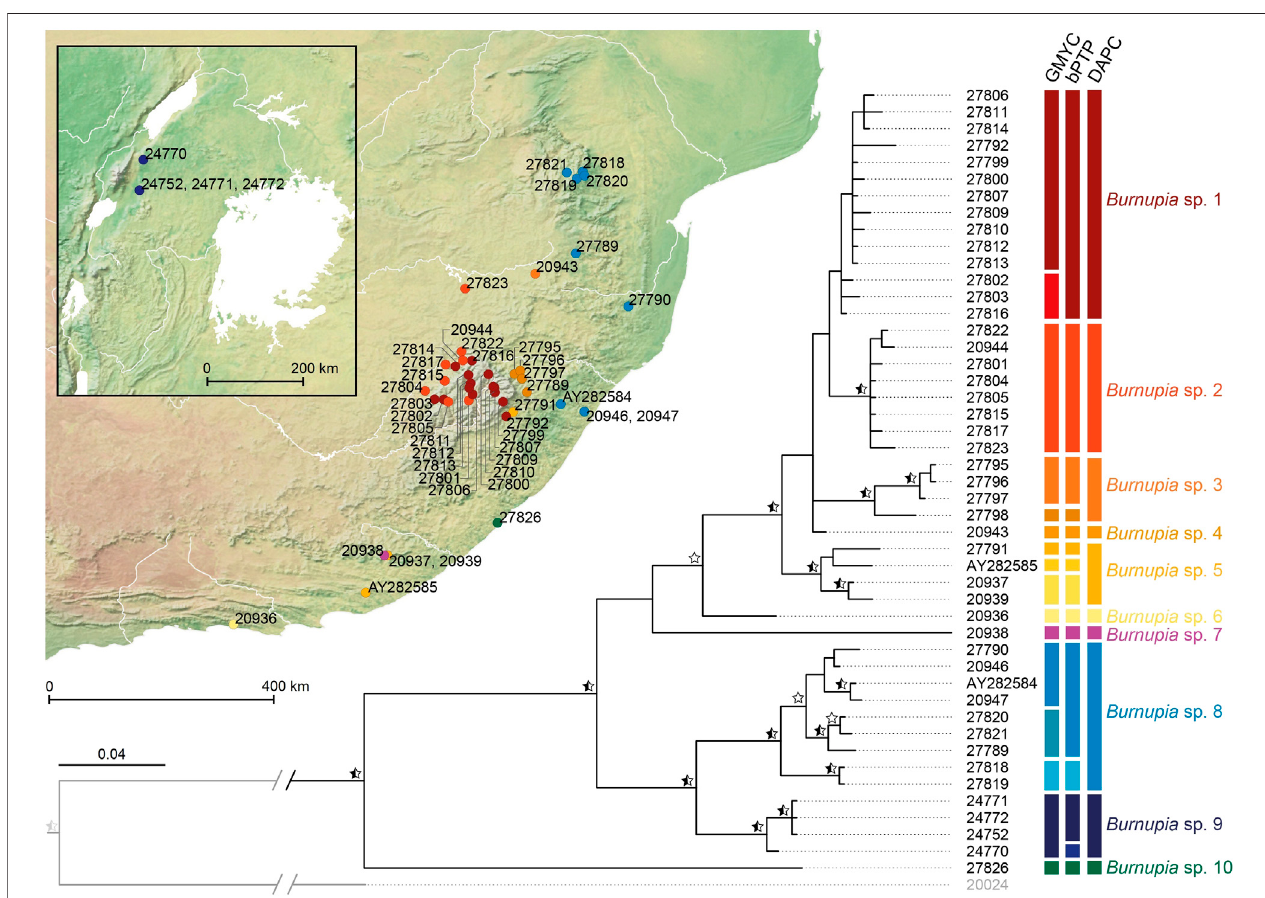
FIGURE 3 | Bayesian phylogeny of Burnupia generated in MrBayes. Supported nodes (PP ≥ 0.95) are marked with black stars. Nodes additionally supported by parsimony analyses (Paup; BS ≥ 70) are marked with white stars or half black/white stars where PP support already exists. Results of the species delimitation methods (i.e., GMYC, bPTP and DAPC) are given alongside the tips in the form of coloured bars where different colours within each method denote different species and shared coloursacrossmethodsindicatesharedspecies.AdistributionmapwithdotscolouredandfollowingtheDAPCderivedspeciesarealsopresented.Furtherdetails on the samples and localities can be found in Table 1 following the specimen alphanumeric